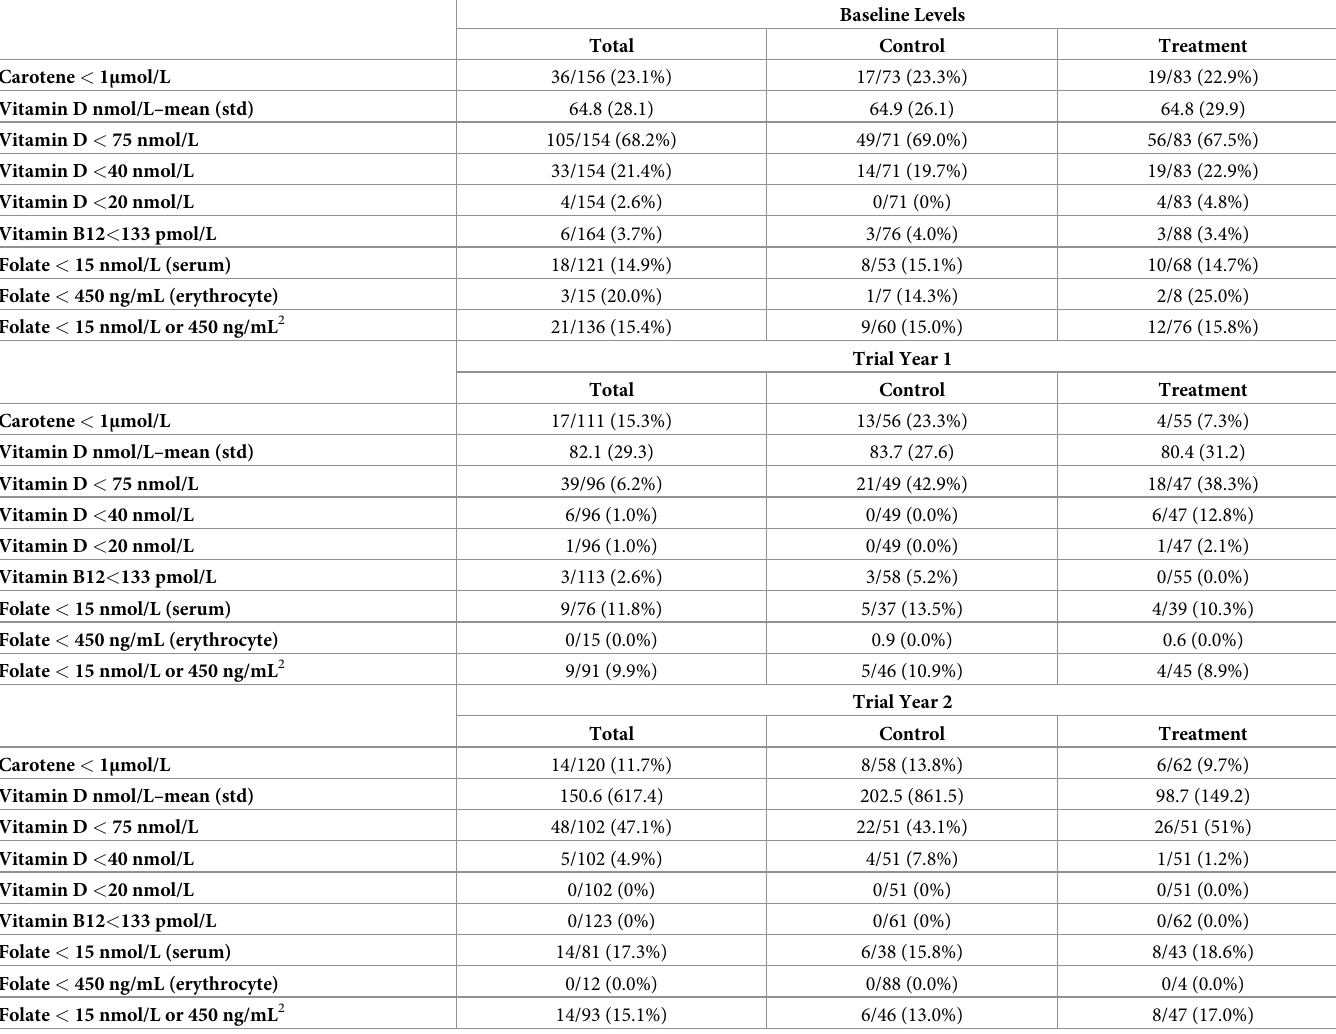
Table 3. Number of MAINTAIN participants with micronutrient deficiencies over the study period (n = 171) 1